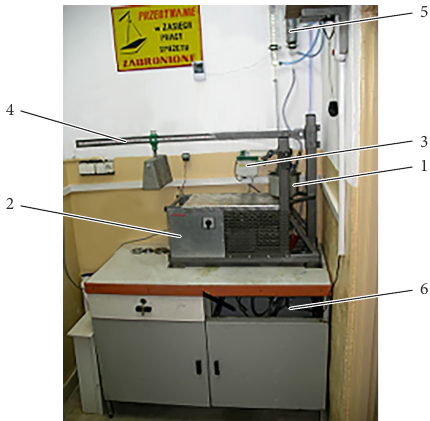
Figure 1. The test bench to determine lubrication and resistance of materials to wear: 1 – the shield of friction node; 2 – the base and the drive of friction machine; 3 – measuring system of the friction moment; 4 – weighing arm; 5 – temperature stabilization system of the tested lubricant; 6 – circulation system and lubricant filtration (Gardyński 2005)